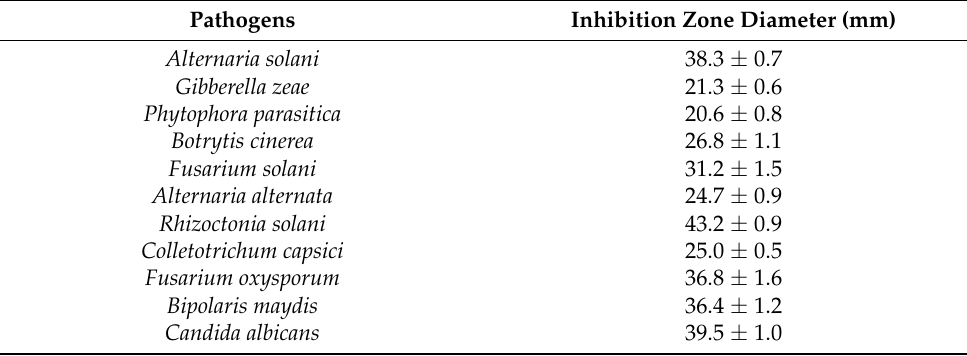
Table 2. Antimicrobial spectrum of compound 4 against test